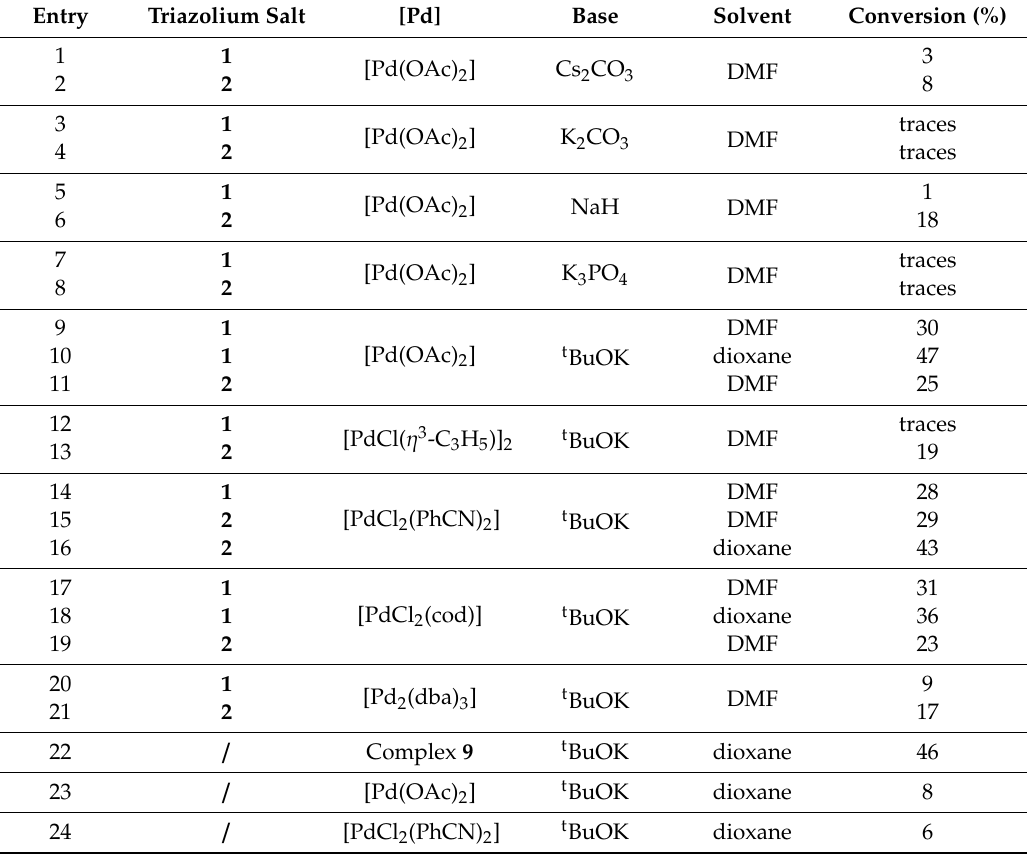
Table 1. Suzuki–Miyaura cross-coupling reaction of 4-chloroanisole with phenylboronic acid—a search for optimal catalytic conditions.